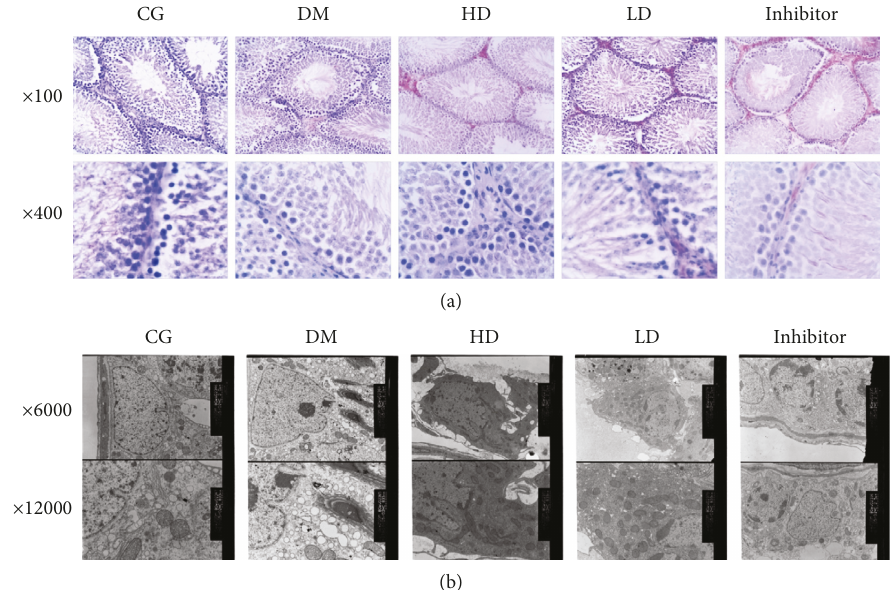
Figure 1: (a) Histopathological changes in testicular tissue under a light microscope (stained with hematoxylin and eosin dye, × 100, × 400). (b) Histopathological changes in testicular tissue under a transmission electron microscope ( × 6000, × 12000). Histological assessment under a light microscope showed that testicular tissues from the DM group exhibited extensive, loose interstitial cells and visible interstitial atrophy. The testicular tissue sections of the HD and LD groups exhibited slightly more active, spermatogenic cells that were arranged more closely, and a more signi fi cant number of interstitial cells. The histological properties of the CG group were superior to those of the above three groups. Based on transmission electron microscopy, the organelles of the testis tissue exhibited atrophy; the mitochondria, endoplasmic reticulum, and other organelles exhibited vacuoles; and the mitochondrial ridge was widened and dissolved. These changes were not observed in the interstitial cells in the CG group. The histological properties in the HD and LD groups showed altered expressions levels between the CG and DM groups. The level measured in the inhibitor group was slightly lower than that in the HD